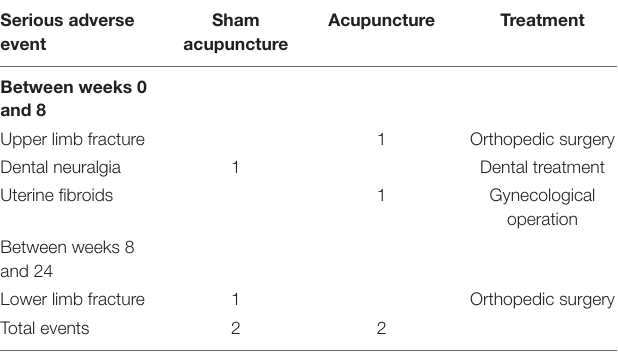
TABLE 8 | Adverse events in patients with primary Sjögren syndrome by